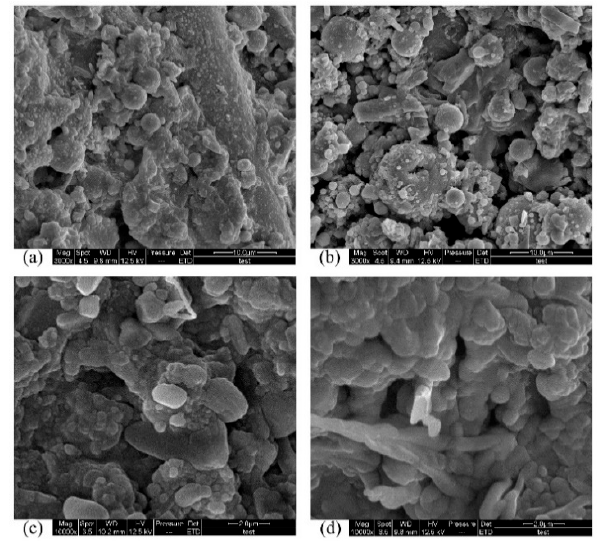
Figure 11. Surfaces of NPG, ( a ) and ( c ), and LPG, ( b ) and ( d ), that were immersed in pH 0.5 acid solution.